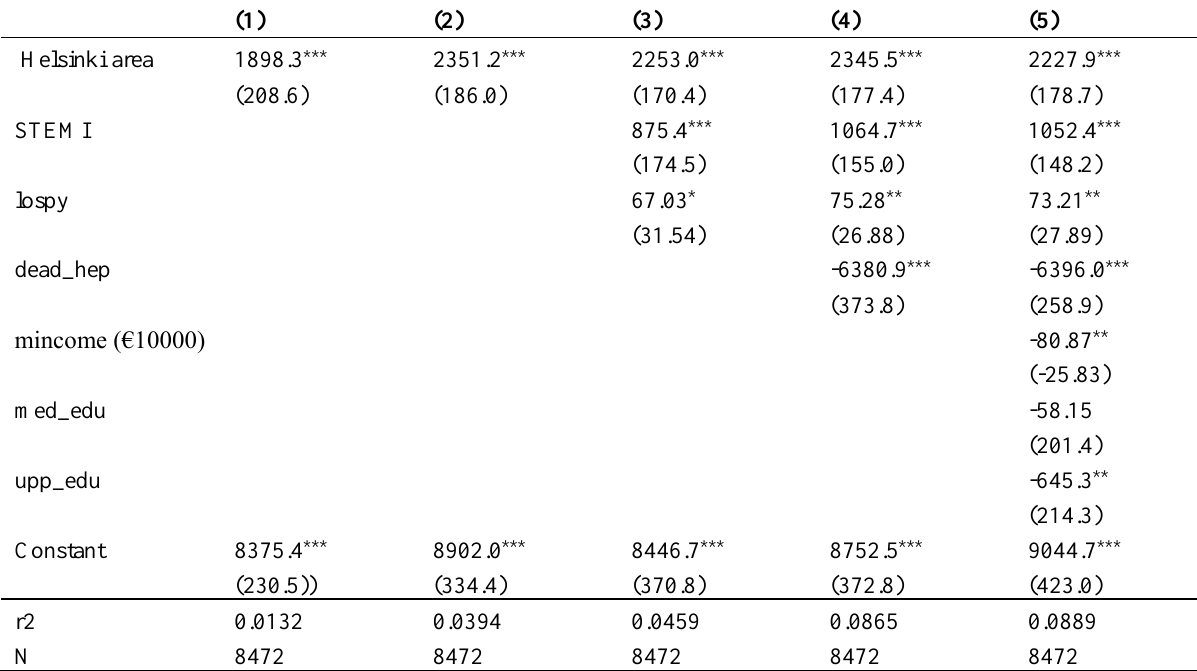
Table A3: First institutional episode cost comparison by OLS – capital areas